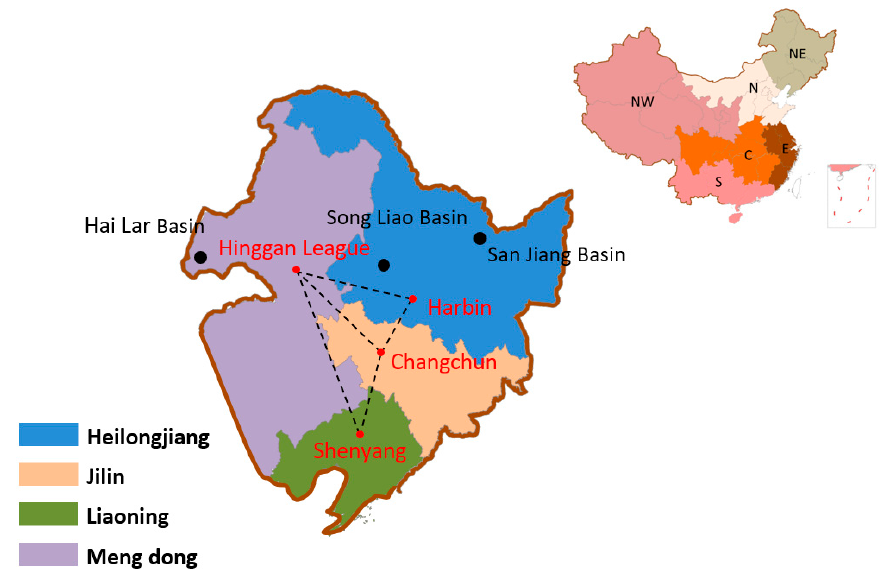
Figure 1. The Northeast Power Grid region and main storage location schematic diagram.